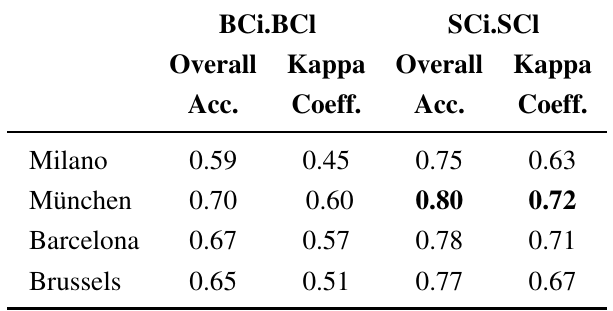
Table 3. Overall accuracies and Kappa coefficients obtained from a cross-city model with background knowledge training (using all 50 predictors).